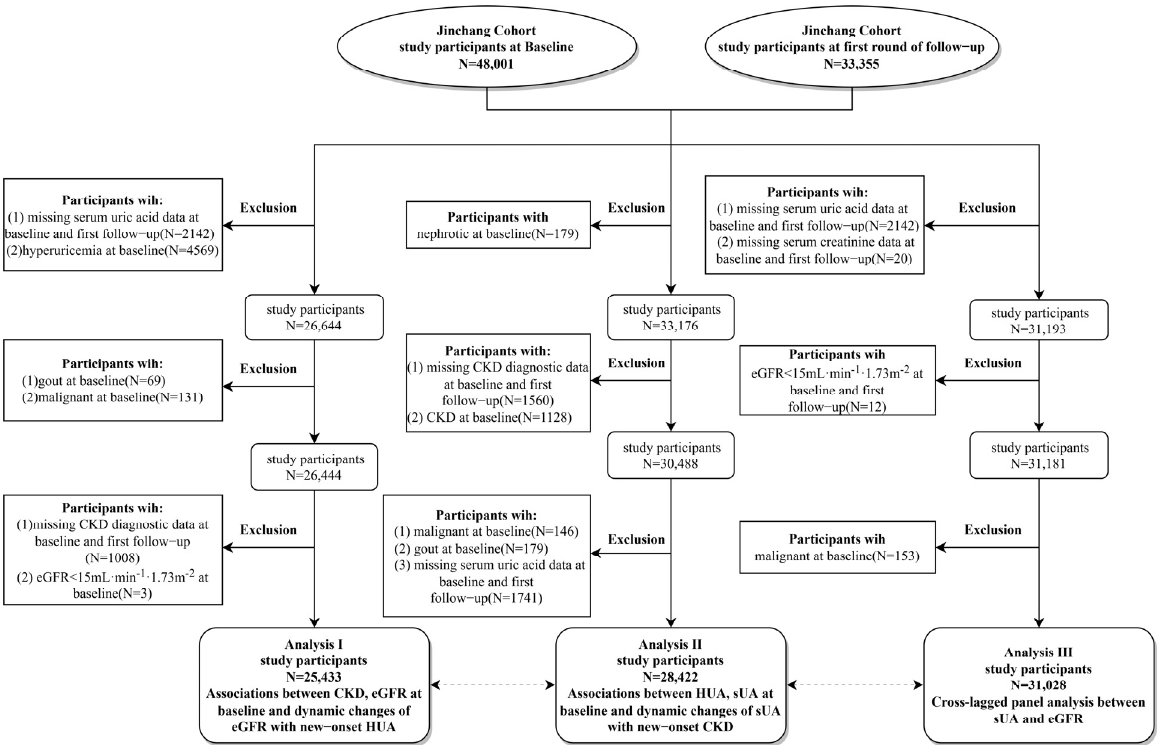
Figure 1. Inclusion and exclusion criteria and flow chart of study participants. sUA, serum uric acid; eGFR, estimated glomerular filtration rate; HUA, hyperuricemia; CKD, chronic kidney